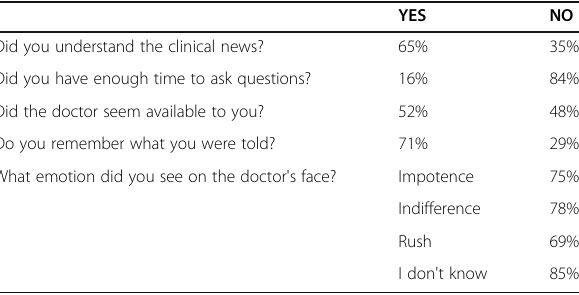
Table 2 (abstract A166).